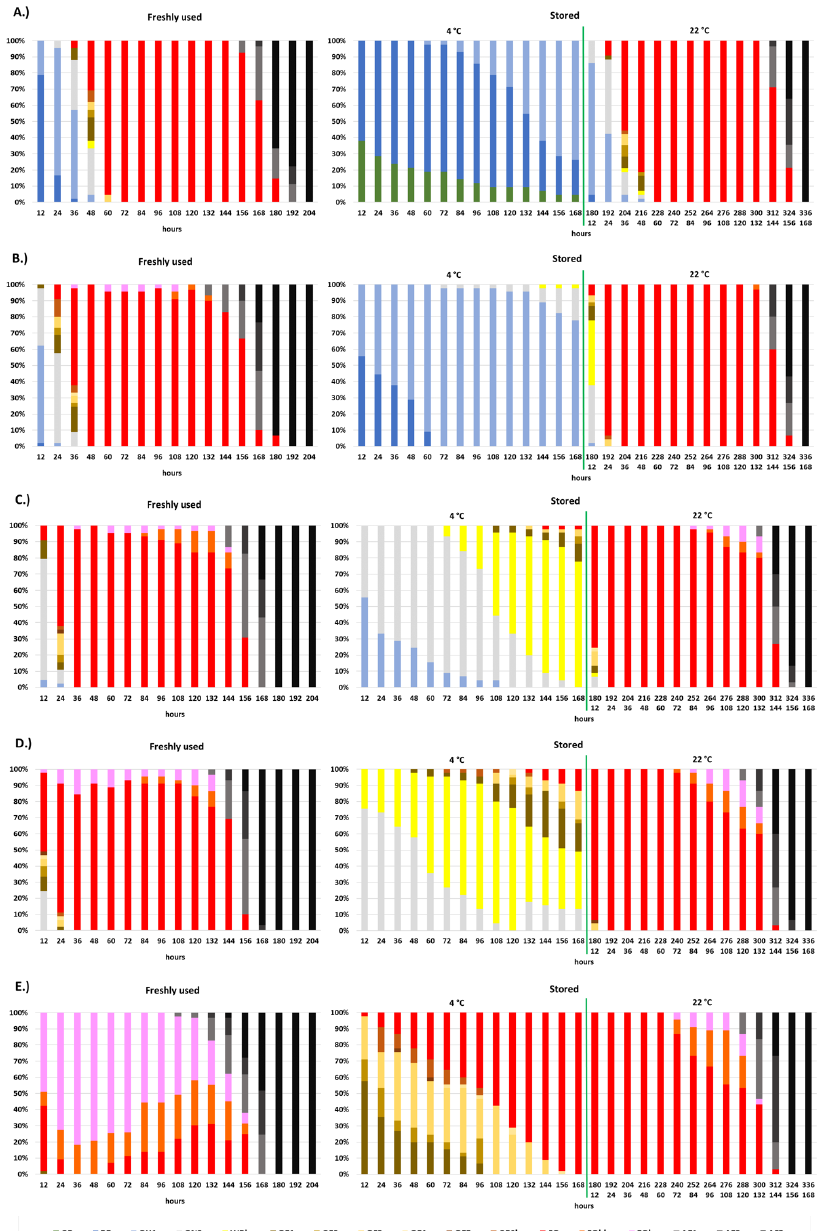
Figure 5. The development of flowers harvested during the green bud stage: (( A ) harvested during the green bud stage; ( B ) harvested during the pencil stage; ( C ) harvested during the goose neck 1 stage; ( D ) harvested during the goose neck 2 stage; ( E ) harvested during the goose neck 3 stage). (GB = green bud; PE = pencil stage; GN1 = goose neck 1 stage; GN2 = goose neck 2 stage; WBh = goose neck 2/3 stage, with hanging buds; OF1,2,3,4,5 = opening flower with 1, 2, 3, 4, or 5 opened tepals; OF6h= opening flower with 6 half-open tepals; FO = open flower, tepals are in a plane; FOhb = open flower, tepals are half backwards; FOb = open flower, tepals are backwards; AF1 = tepals become membranous, with turgor; AF2 = the tepals start to gather, the corona is still colored with turgor; AF3 = complete wilting, the tepals are shriveled).